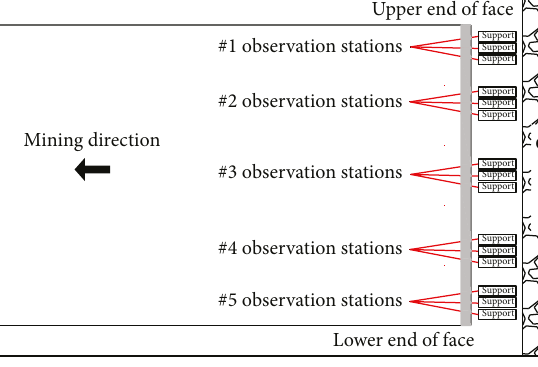
Figure 12: Distribution of observation stations along the dip direction.